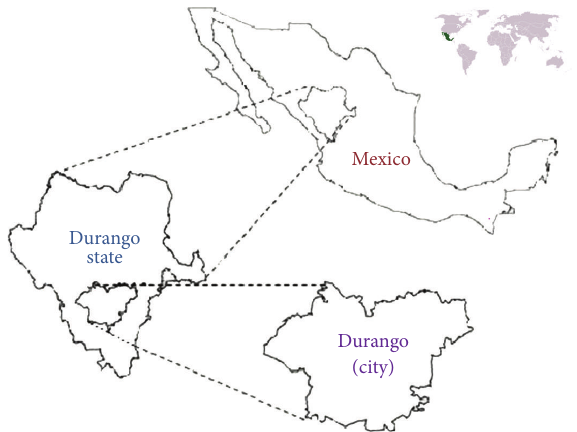
Figure 1: Map depicting the Durango city and state locations in the Mexican